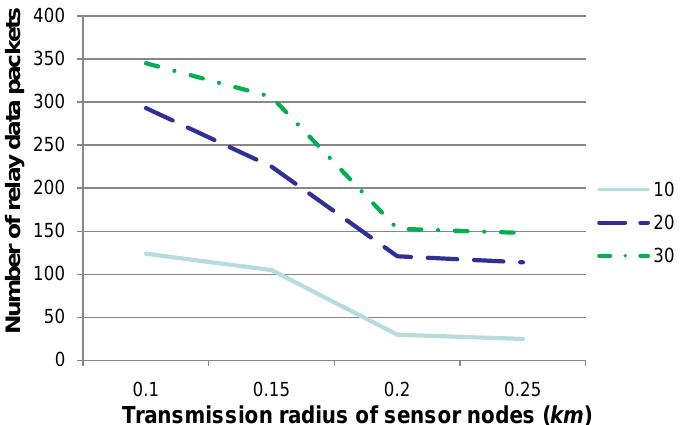
Figure 5. Comparison of the number of relay data packets when the transmission radius r is set to various values. This figure shows that the number of relay data packets declines when the transmission radius is set to a relatively large